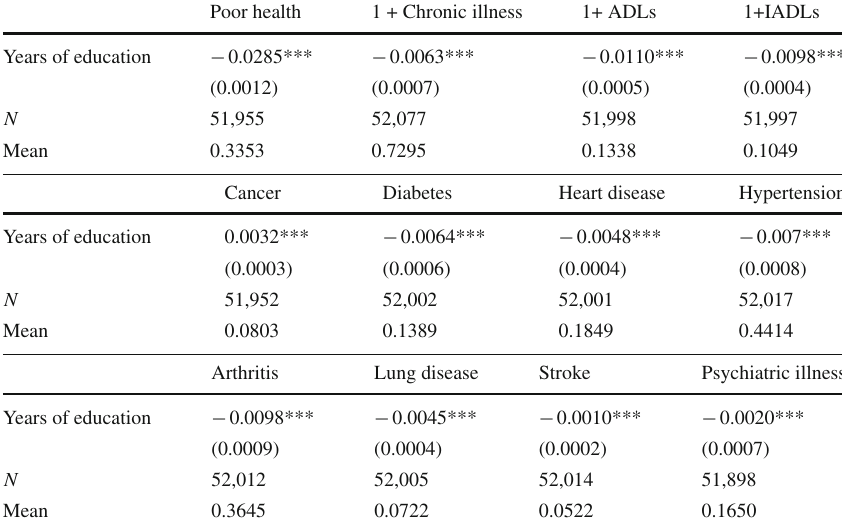
Table5 Probit models of years of education on health outcomes (coefficients reported as marginal effects) Poor